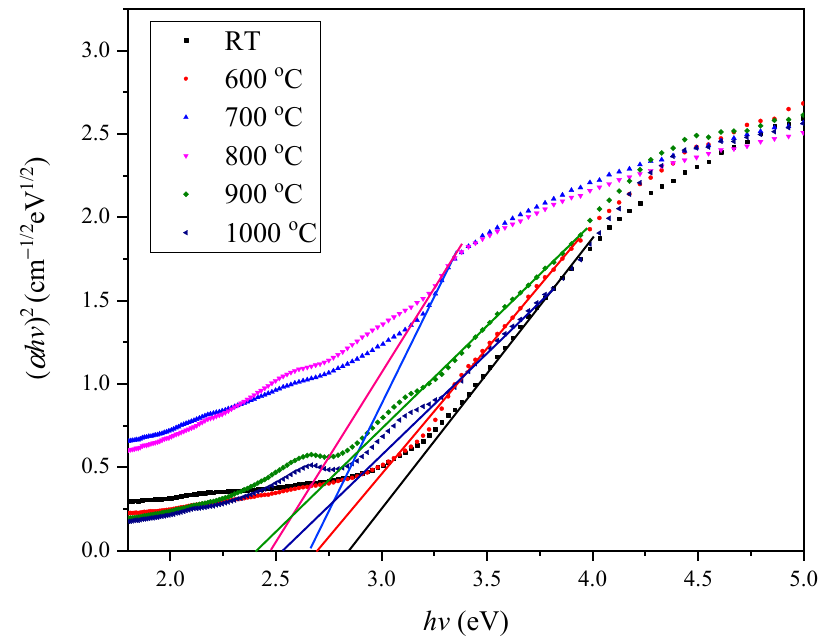
Figure 9. The optical band gap of zinc silicate sintered at different sintering temperatures of RT, 600, 700, 800, 900, and 1000 °C.